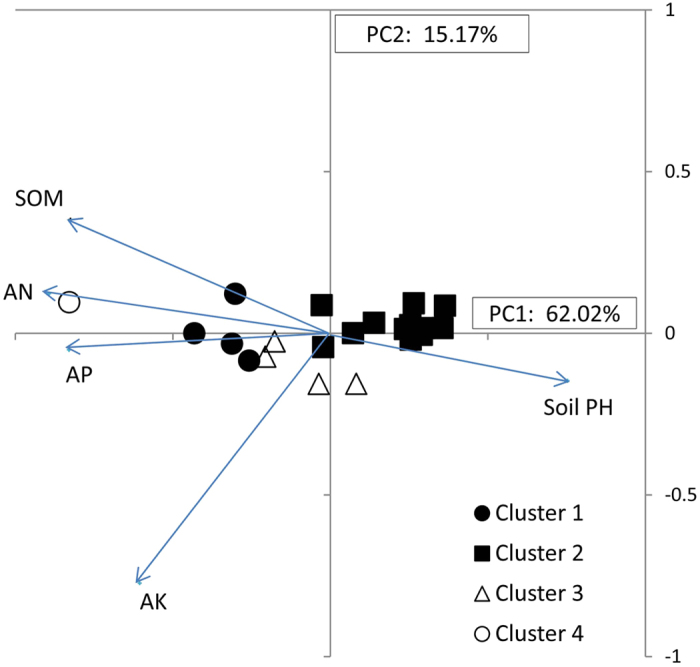
Principal components analysis of 21 soil samples of the common bean production areas.Variable factor loadings for PC1 and PC2 are soil pH and soil nutrient variables and presented as vectors.